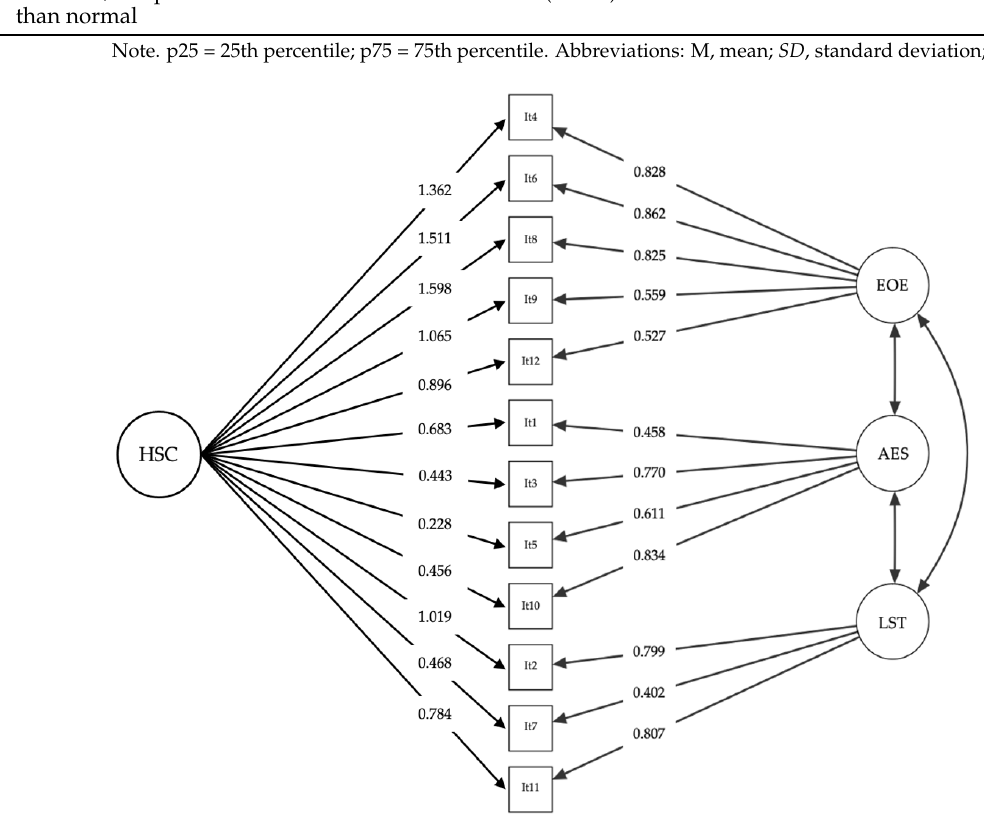
Figure 1. Factor loadings of the one-factor and the three-factor structures of the Spanish version